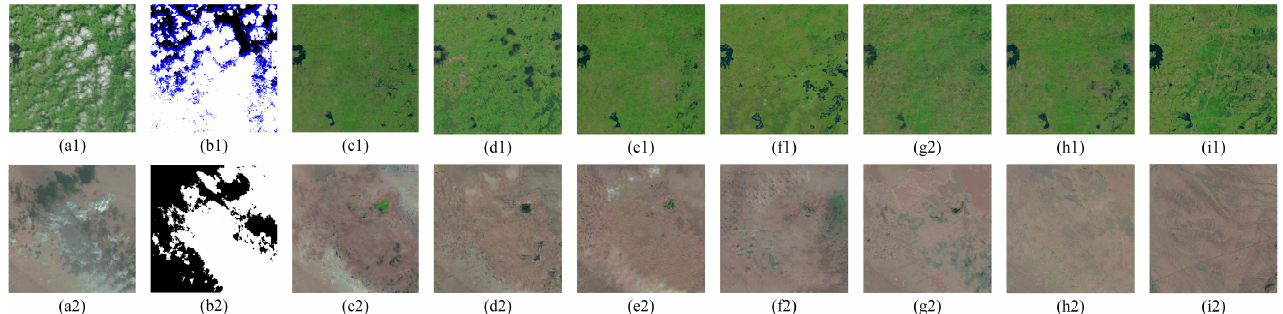
Figure 13. Results of each method in analysing RICE2/(Image1,Image2). ( a ) Cloudy images; ( b ) cloud masks; ( c ) Cloud-GAN; ( d ) cGAN; ( e ) SpAGAN; ( f ) McGAN; ( g ) AMGAN-CR; ( h ) DC-GAN-CL; ( i ) cloud-free images.